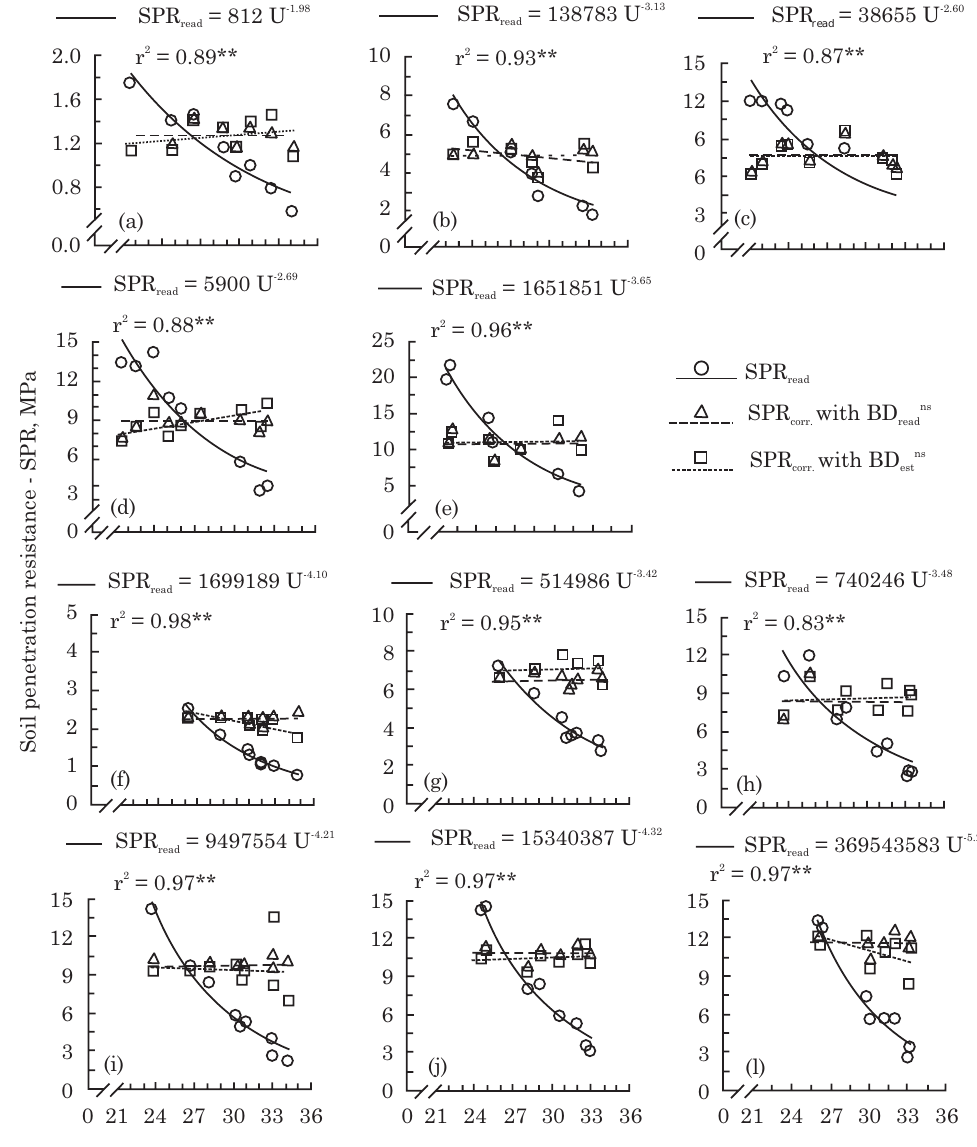
Figure 3. Correction of soil penetration resistance, in function of gravimetric soil water content in a Rhodic Eutrudox, in the 5.5-10.5 cm layer: a) NTCh = no-tillage with chiseling; b) NT = no-tillage without chiseling or additional compaction; c) NTH4 = NT with additional compaction by four harvester passes; d) NTH8 = NT with additional compaction by eight harvester passes; e) NTH10 = NT with additional compaction by 10 harvester passes; and in the 13.5-18.5 cm layer: f) NTCh; g) NT; h) NTH4; i) NTH8; j) NTH10; l) NTH20 = NT with additional compaction by 20 harvester passes. **Significant equations (F test, p<0.01); ns non-significant. SPR corr with BD obs = SPR corrected in function of U by using the soil bulk density observed in the field; SPR corr with BD est = SPR corrected in function of U based on soil bulk density estimated by the pedotransfer functions shown in figure